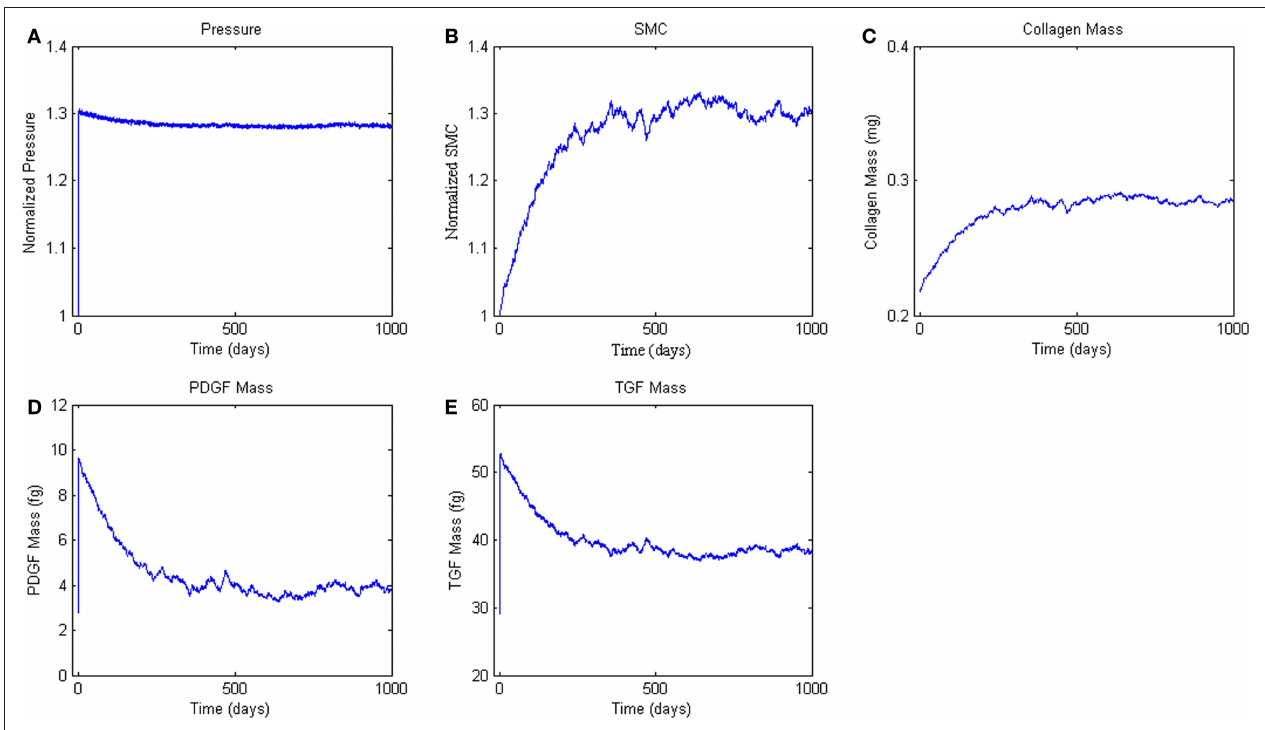
Figure 6 | Agent-based model hypertension response. ABM results are an average of five simulations. Panel (A) ABM is subjected to a step increase in mean arterial pressure of 30%. (B, c) Response of SMC proliferation and